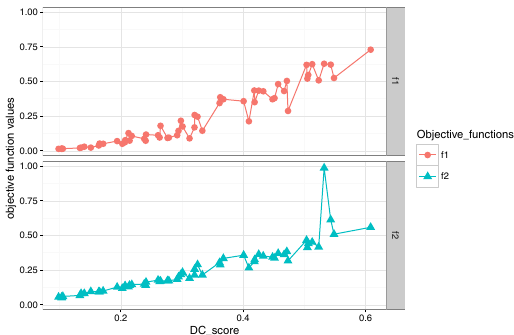
Figure 1. Figure shows the plot of DC _ Score vs objective function values. Values of both objective functions increase with the DC _ Score